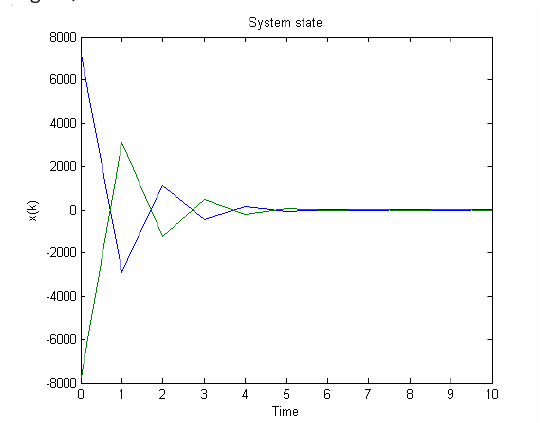
Fig. 7. State curve of closed-loop